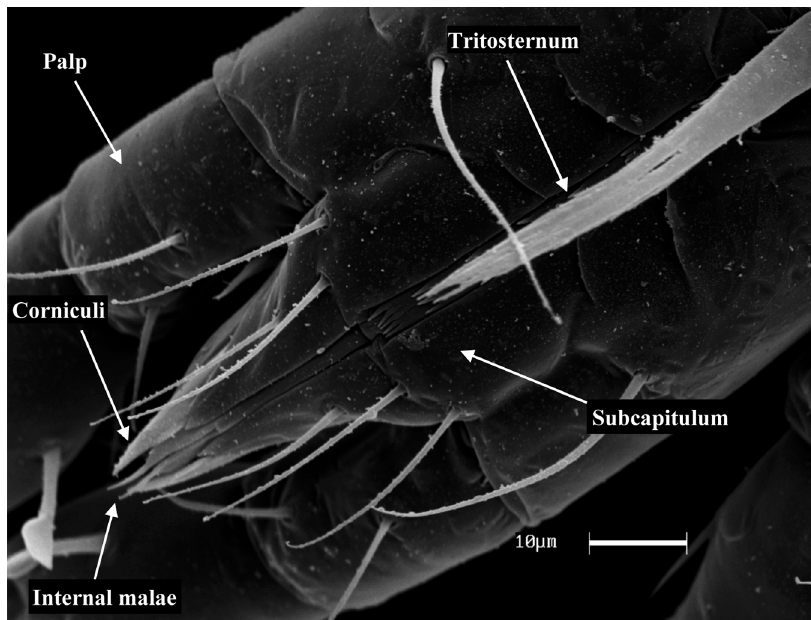
Fig. 5. Ventral view of the gnatosoma of the phyto- seiid mite Typhlodromus exhilaratus (Ragusa).